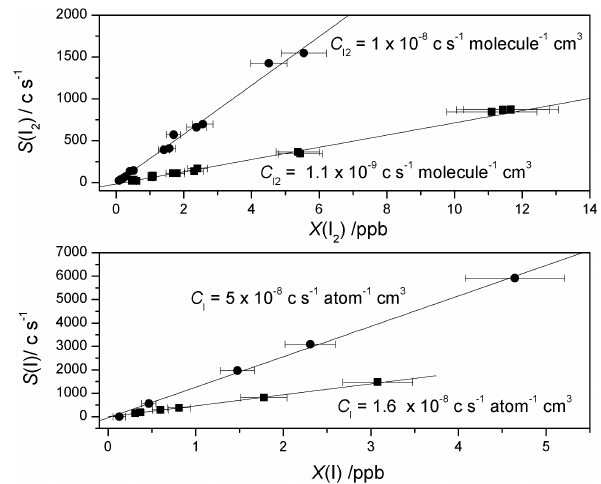
Fig. 8. Examples of calibration fits (4 June 2010 and 5 October 2010, see Table 3). Upper panel: I 2 fluorescence signal vs. I 2 mix- ing ratio in the calibration cell (symbols), and linear fit to the data (solid lines). Lower panel: the same for I